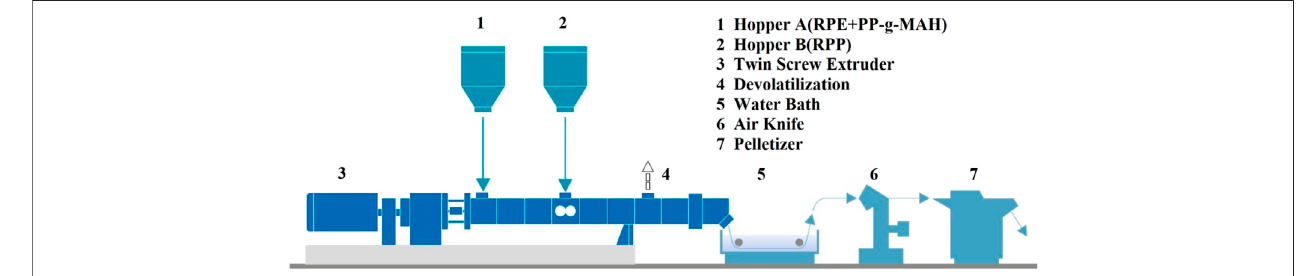
FIGURE 1 | Flow chart of TBM preparation.